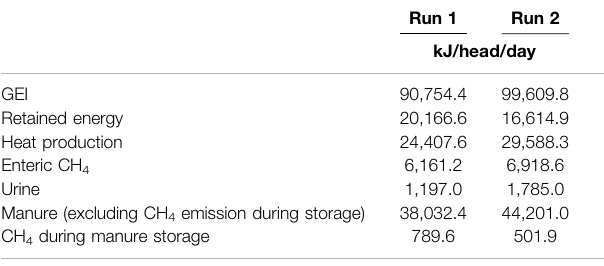
TABLE 3 | Fate of the energy contained in the feedstuff.